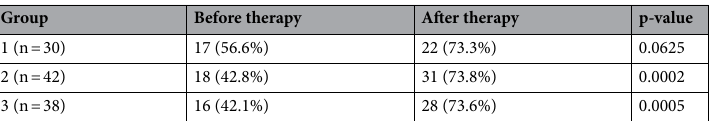
Table 3. Success ratios of Doppler-assisted visualization of uterine spiral arteries before and after the therapy. The data are presented as raw counts and % rates, subject to McNemar’s binomial test.